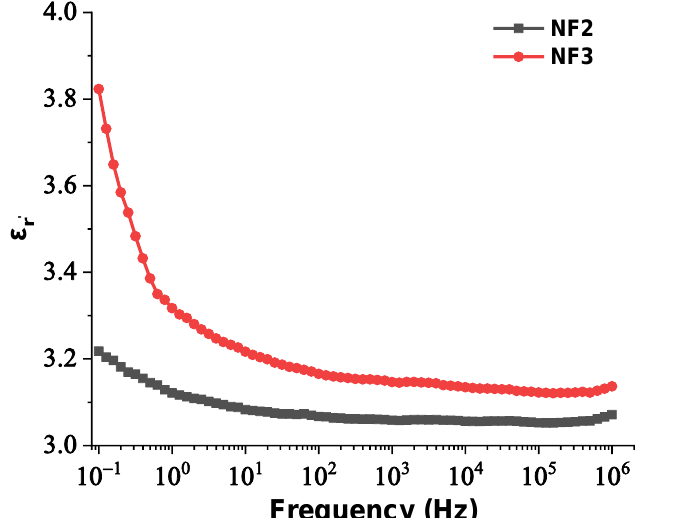
Figure 13. Change in the real part of relative permittivity versus frequency of the NF2 and NF3 samples.